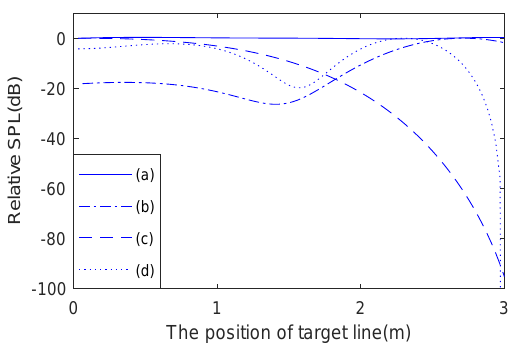
Figure 6. The relative sound pressure level (SPL) distribution in the target line with ( a ) adaptive genetic algorithm (GA), ( b ) delay and sum beamformer, ( c ) contrast maximization, and ( d ) least squares (LS)-based pressure matching approaches.